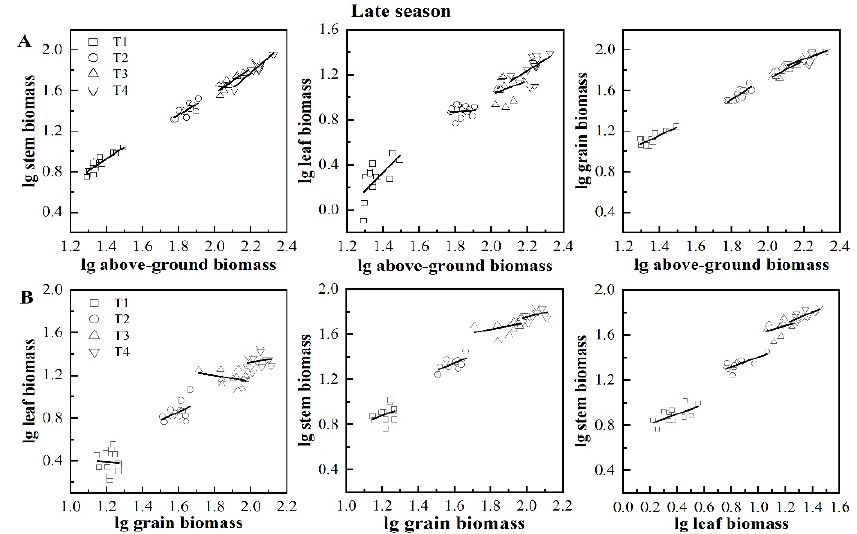
Figure 5. The allometric relationship between total aboveground biomass and organ biomass ( A ) and between organ and organ biomass ( B ) in late season rice. Note: T1, 1 seeding per hill + row spacing 12.93 cm; T2, 3 seedings per hill + row spacing 22.33 cm; T3, 6 seedings per hill + row spacing 31.67 cm; T4, 9 seedings per hill + row spacing 38.80 cm.